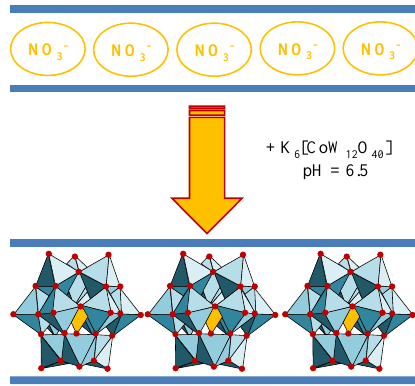
Figure 13. Synthesis route of polyoxotungstates-LDH (POW-LDH) Adapted from Ref. [103], Copyright 2008, Elsevier.